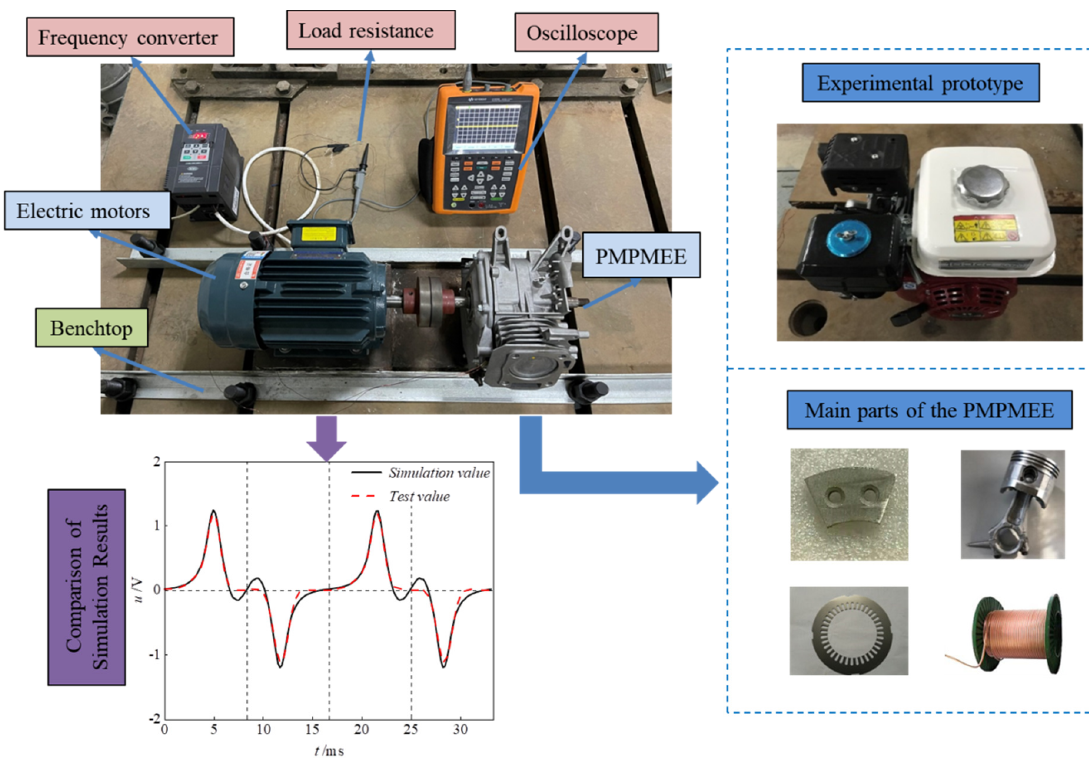
Figure 12. Test and results of the PMPMEE.